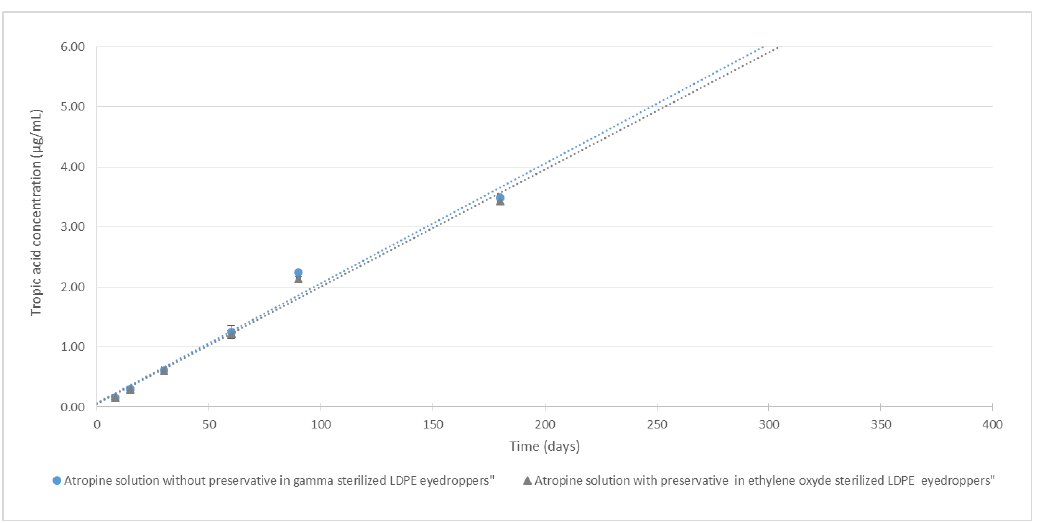
Figure 6. Evolution of breakdown product (tropic acid) concentration during time ( n = 5, mean ± 95% confidence interval): The grey curve is the atropine solution with preservative conditioned in LDPE CAT ® eyedroppers. The blue curve is the atropine solution without preservative conditioned LDPE NOVELIA ® eyedroppers. The dotted lines are the linear regression of the evolution of breakdown product concentrations.